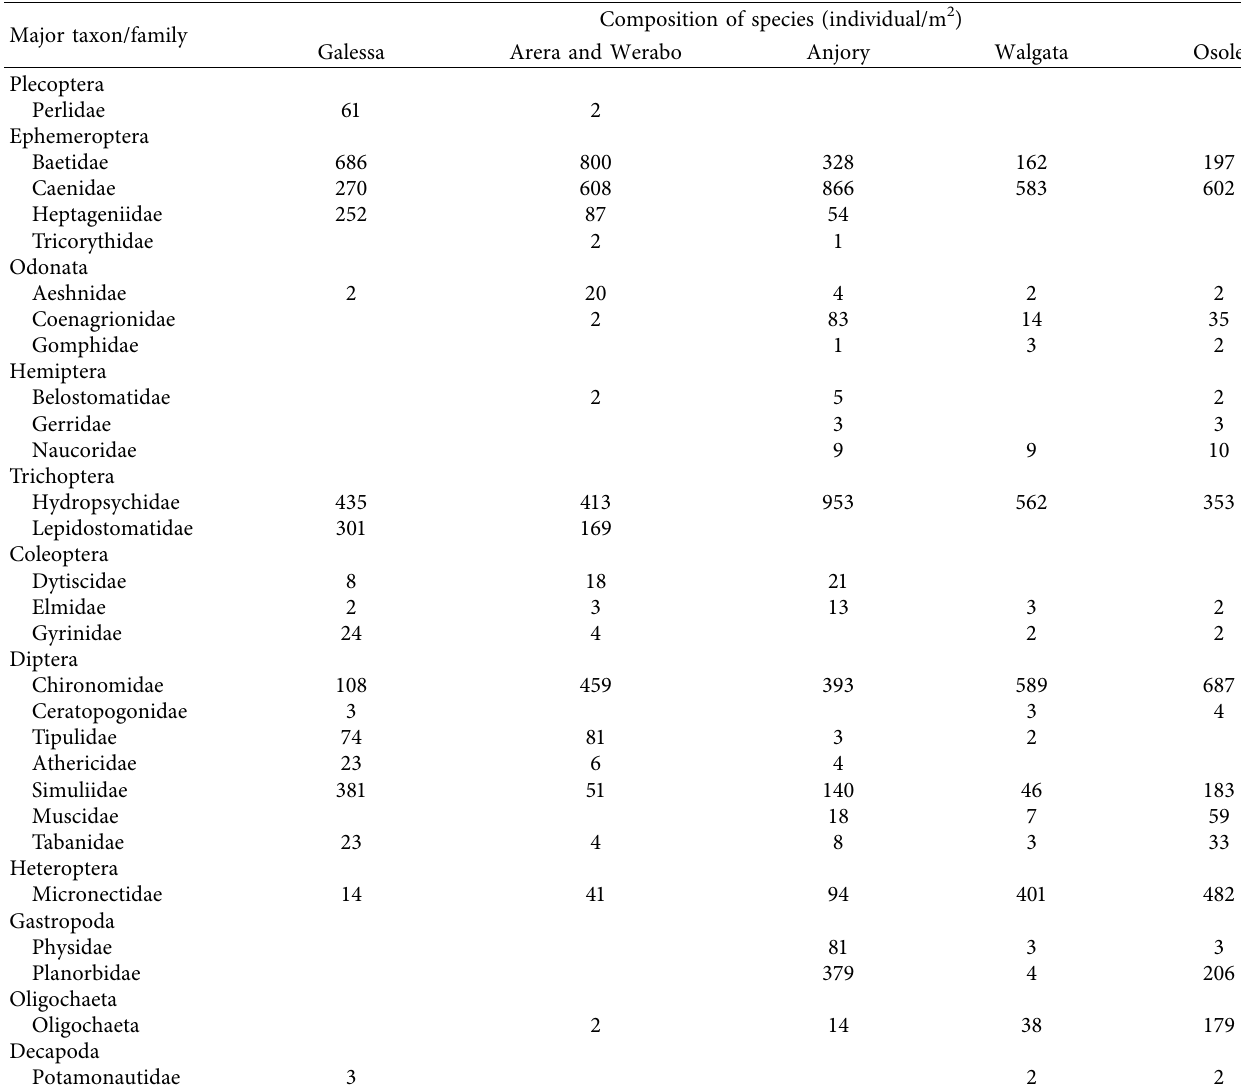
Table 2: Taxa/families identified from the five sampling sites of upper Awash river at Chilimo Forest for a period of three months